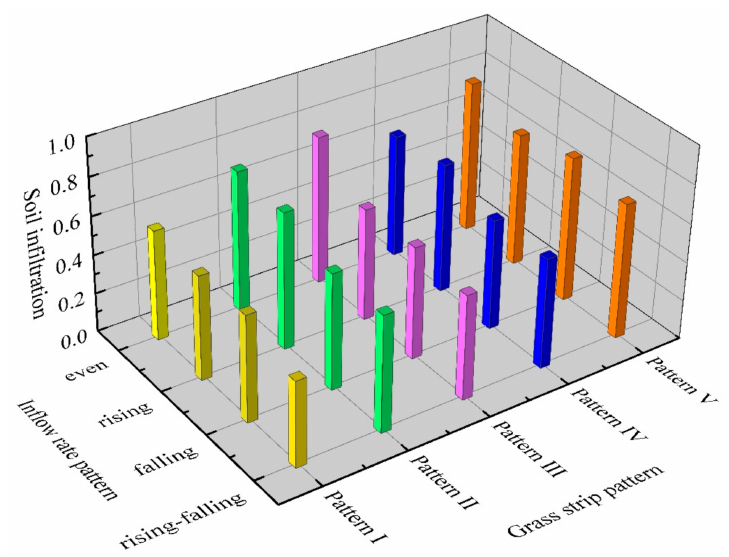
Figure 5. Average soil infiltration under different treatments.